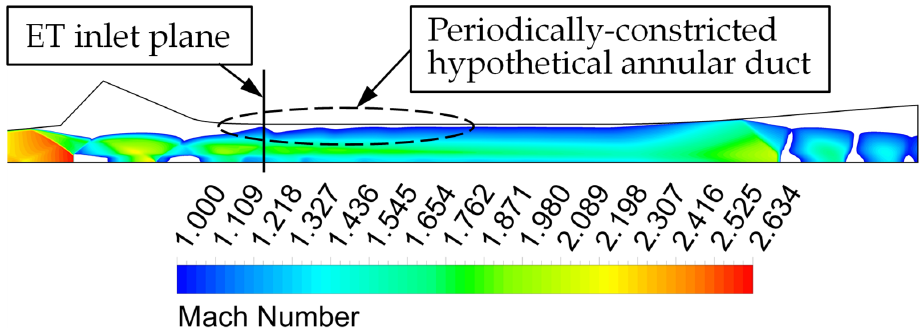
( b ) Figure 8. Qualitative comparison of the non-dimensional wall pressure ( 𝑃 (cid:3050) /𝑃 (cid:2870) ) along the mixing section up to the diffuser between Han et al.’s work ( a ) and the current work (turbulence model: transition SST; 𝑃 (cid:2868) = 618 kPa) ( b ). The left figure ( a ) is reprinted from the work of Han et al. [25] with the wall pressure ( 𝑦 -axis) is non-dimensionalized by the